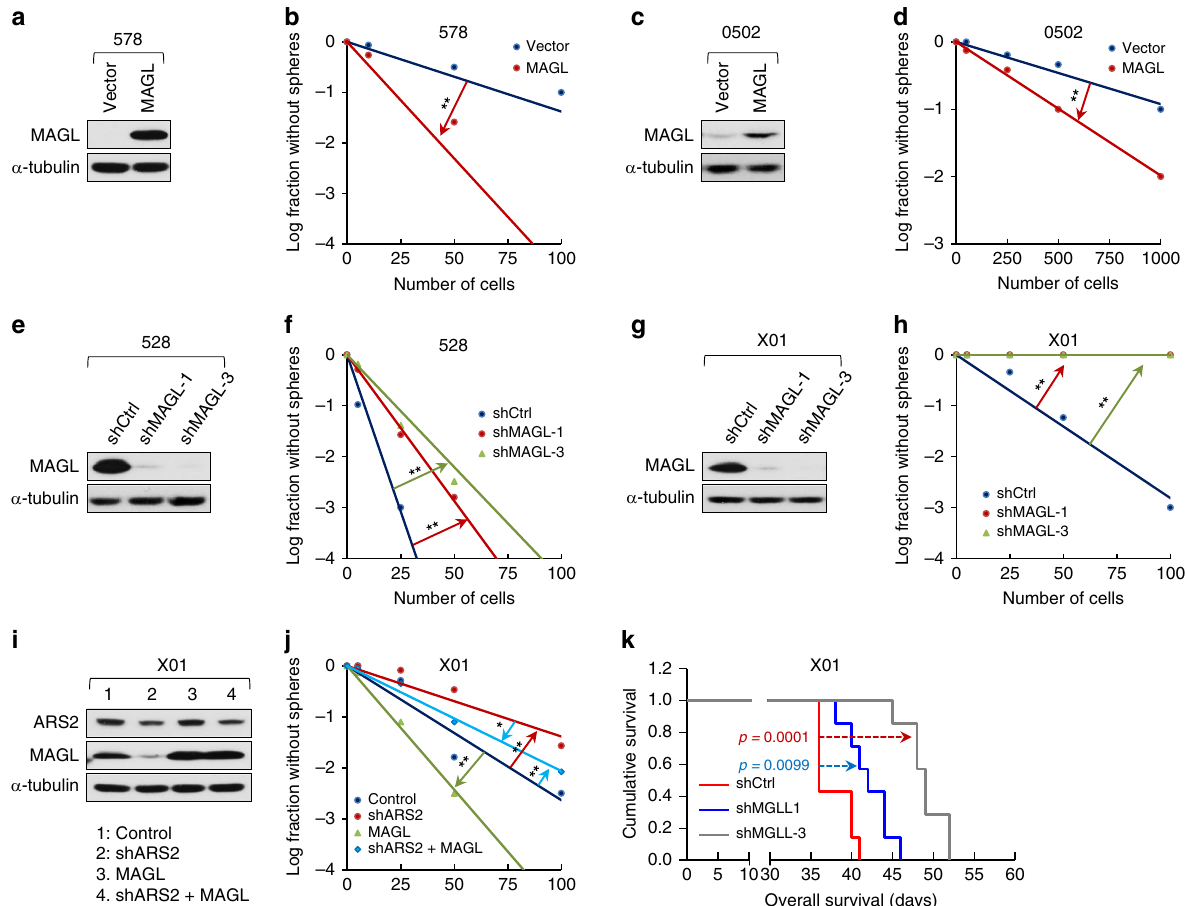
Fig. 4 MAGL regulates the self-renewal and tumorigenesis of GSCs. a Immunoblot (IB) analysis of MAGL in GSCs (578 cells) infected with a MAGL- expressing lentiviral or vector construct. α -tubulin was used as a loading control. b Limiting dilution assays (LDAs), performed in 578-vector and 578- MAGL cells. ( n = 24, ** P < 0.01, t -test). c IB analysis of MAGL in GSCs (0502 cells) infected with a MAGL-expressing lentiviral or vector construct. α - tubulin was used as a loading control. d LDAs, performed in 0502- vector and 0502-MAGL cells. ( n = 24, ** P < 0.01, t -test). e IB analysis of MAGL in GSCs (528 cells) infected with a shMAGL-expressing lentiviral or shCtrl construct. α -tubulin was used as a loading control. f LDAs, performed in 528-shCtrl, 528-shMAGL-1, and 528-shMAGL-3 cells. ( n = 24, ** P < 0.01, t -test). g IB analysis of MAGL in GSCs (X01 cells) infected with a shMAGL-expressing lentiviral or shCtrl construct. α -tubulin was used as a loading control. h LDAs, performed in X01-shCtrl, X01-shMAGL-1, and X01-shMAGL-3 cells. The well- formed sphere was counted at day 16. ( n = 24, ** P < 0.01, t -test). i IB analysis of ARS2 and MAGL in GSCs (X01 cells) infected with a shARS2- or MAGL- expressing lentiviral construct, both shARS2- and MAGL-expressing lentiviral constructs, or a shCtrl construct. j LDAs, performed in GSCs (X01 cells) infected with a shARS2- or MAGL-expressing lentiviral construct, both shARS2- and MAGL-expressing lentiviral constructs, or a control construct. The well-formed sphere was counted at day 7. ( n = 24, * P < 0.05, ** P < 0.01, t -test). k Kaplan – Meier survival analysis of mice implanted with X01 cells infected with shMAGL-expressing lentiviral or shCtrl construct ( n = 7; 2 × 10 4 cells injected per mouse, log-rank test). Median survival of the orthotopic mice injected with X01-shCtrl, X01-shMGLL-1, or X01-shMGLL-3 was 36 days, 42 days, and 49 days, Previous studies have suggested that PGE 2 – stimulated As expected, MAGL or ARS2 knockdown in 528 and X01 cells β -catenin accumulation and the activation stimulates stemness in leukemia stem cells, growth of colon cancer cells, and and Supplementary Fig. 5f, g). Moreover, treatment with PGE 2 manner in association with enhanced LRP6 phosphorylation (Fig. 5e). The sphere-forming ability of GSCs was also increased in a concentration-dependent manner by treatment with PGE 2 (Supplementary Fig. 5h), an effect that was blocked by the Fig. 5b – e). Knockdown of MAGL simultaneously decreased speci fi c inhibitor of TCF/ β -catenin-mediated transcription, PGE 2 production and β -catenin accumulation in GSCs (Fig. 5a, b and Supplementary Fig. 5b – e). Since β -catenin expression is ICG-001 (Fig. 5f, g) 27 . Treatment of GSC 528 and X01 cells with ICG-001 signi fi cantly reduced GSC sphere-forming ability closely related with its role in transcriptional activation, we through downregulation of TCF/ β -catenin-mediated cyclin D1 determined whether ARS2 or MAGL affects the β -catenin and c-Myc transcription (Fig. 5h, i and Supplementary Fig. 5i, expression. We measured β -catenin protein levels in fractio- j). Collectively, these fi ndings strongly suggest that MAGL nated nuclear or cytosolic lysates after ARS2/MAGL knock- regulates GSC self-renewal through PGE 2 /pLRP6/ β -catenin down. The successful fractionation of nuclear and cytosol signaling. proteins was validated with Lamin B and β -actin, respectively.